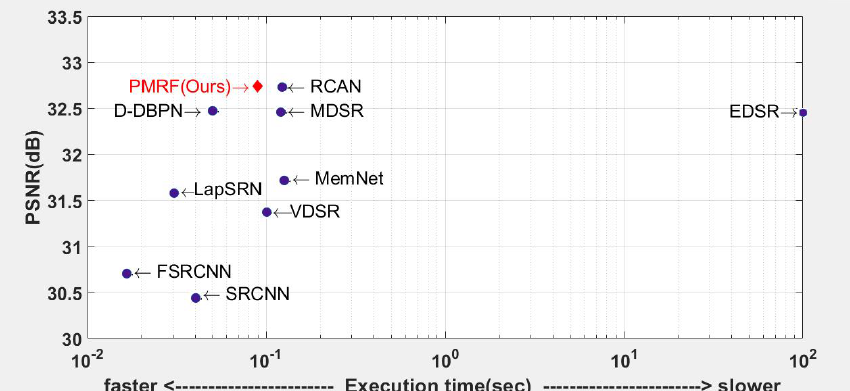
Figure 21. Performance and execution time evaluated on the Set5 dataset at × 4